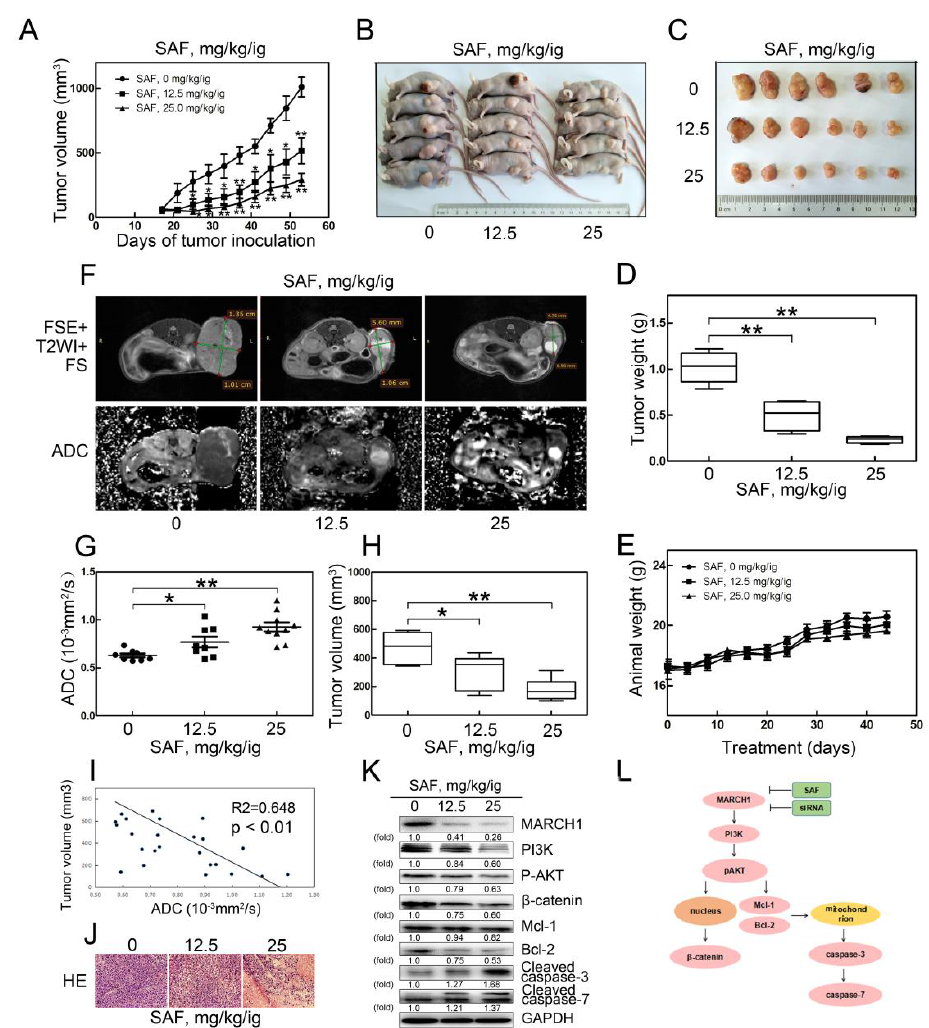
Figure 6. SAF significantly reduces HCC xenograft tumor growth via the MARCH1-mediated inhibition of the downstream PI3K/AKT/ β -catenin pathway in vivo. ( A ) Tumor growth curves of the three SAF therapy groups (0 mg/kg/ig, 12.5 mg/kg/ig, 25 mg/kg/ig). ( B – C ) Representative images of mice and tumors in the three SAF treatment groups. ( D ) Tumor weight in the untreated and treated mouse groups. ( E ) Body weight changes of mice in the untreated and treated groups. ( F ) T2-weighted MR images and ADC maps of the SAF-treated mice. ( G ) Average ADC values of tumors from untreated and treated mice. ( H ) Average volume of tumors from untreated and treated group mice measured on T2WI. ( I ) Negative correlation between ADC value and tumor volume. ( J ) Representative images of H-E staining in HCC xenograft tumor sections, magnification 40x. ( K ) Protein expression of MARCH1, PI3K, P-AKT, β -catenin, MCL-1, BCL-2, cleaved caspase-3 and cleaved caspase-7 in xenografts of SAF untreated and treated mice. ( L ) A schematic diagram illustrating the underlying anticancer mechanism of SAF on hepatocellular carcinoma, as measured by western blotting. All data in this figure are presented as means ± SD. ** p < 0.01, * p < 0.05. MRI was used to research the tumor responses to SAF therapy in our study. The apparent diffusion coefficient (ADC), as a quantitative parameter of DW-MRI, is usually used as an early